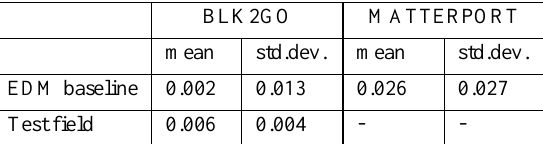
Table 1. Statistics on distance comparisons